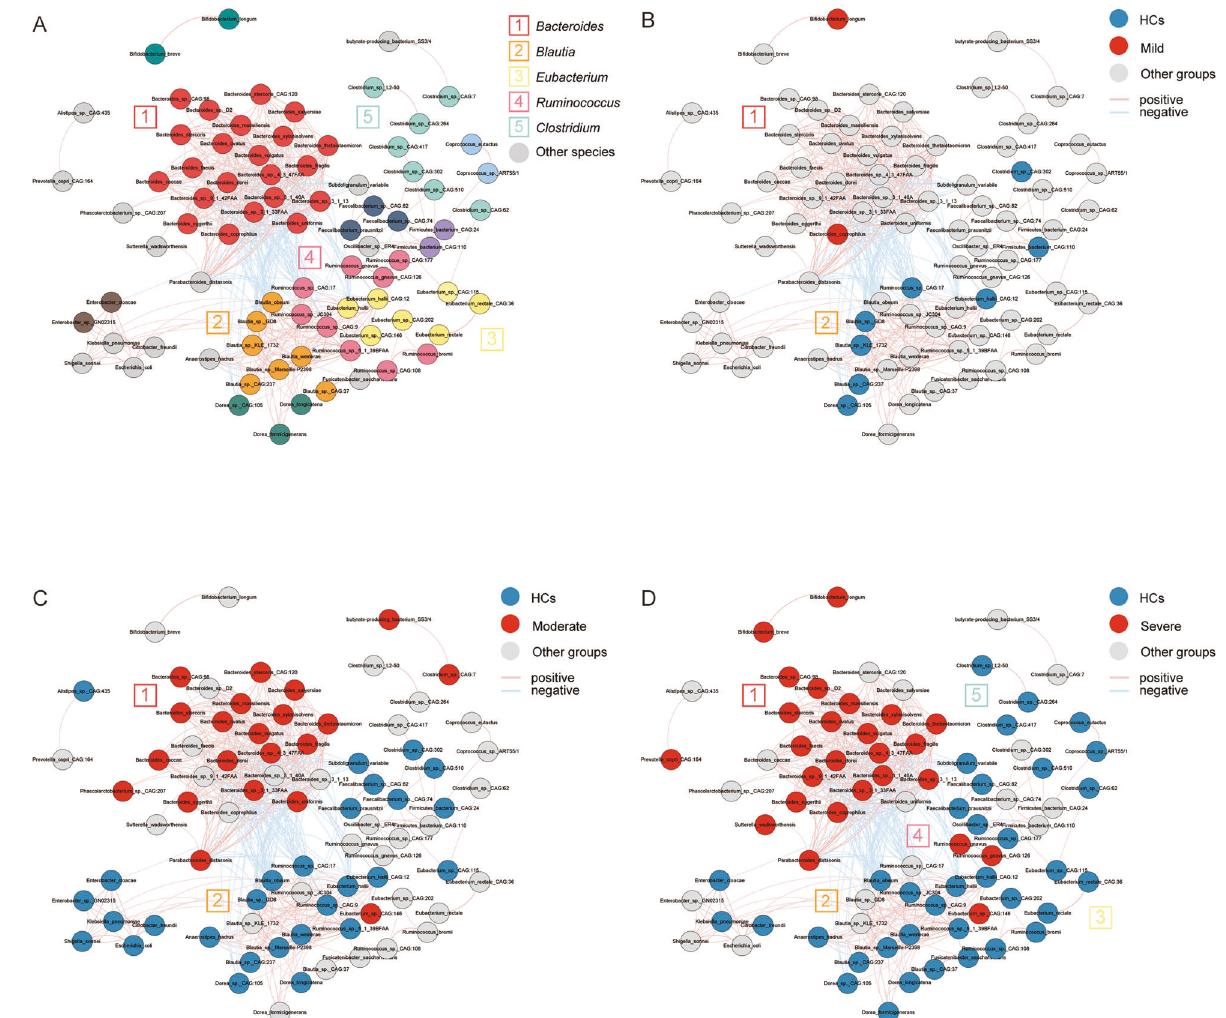
Fig. 4 The co-occurrence network constructed from the relative abundance of differentially enriched bacteria species among HCs and MDD subgroups. The network was mapped based on the result ( p < 0.05, r 2 > 0.25). A Correlation among abundances of all differentially enriched bacteria were analyzed with SparCC algorithm, clusters were assigned a particular color and main clusters had a corresponding number. B , D Species enriched in MDD subgroups were highlighted in red and depleted ones were in blue. Pink lines represented positive correlations and blue lines means negative correlations. B Bacteria altered little in mild group, some scattered species were depleted in mild groups associated with each other weakly and had no correlation with the only enriched Bacteroides in cluster 1. C Bacteria enriched in moderate groups were almost all belong to Bacteroides in cluster 1, the major depleted genus was Blutia in cluster 2, which have a signi fi cantly negative association with Bacteroides . D Gut microbiota of severe group appeared fi erce disturbance featured with markable increase of Bacteroides in cluster 1. Ruminococcus , Blautia , Eubacterium and Clostridium (cluster 2, 3, 4, 5) were obviously decreased as a group. There were complex positive correlations within cluster 2, 3, 4 and a signi fi cantly negative correlation between the decreased group and Bacteroides . It revealed that there was a potential antagonistic relationship between the decreased group and Bacteroides